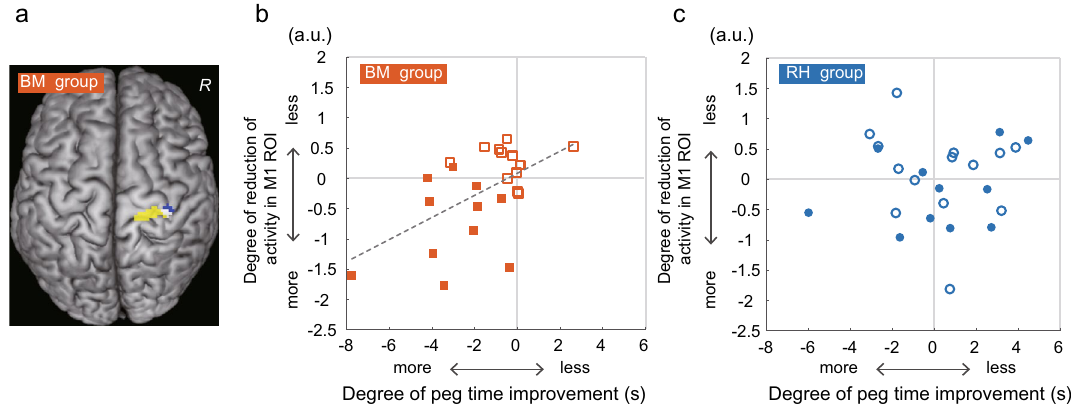
Figure 5. Relationship between the degree of reduction in ipsilateral M1 activity and peg time improvement. ( a ) Significant cluster (yellow and white areas) in which the degree of activity reduction was correlated with peg time improvement in the BM group. The cluster is superimposed on the MNI brain. ( b , c ) Relationship between the degree of reduction of activity (a.u.; vertical axis) in the M1 ROI (blue and white areas in panel a ) and peg time improvement (s; horizontal axis) in each group ( b for the BM group, c for the RH group). In each panel, the filled symbols represent data obtained from the participants who exhibited ipsilateral M1 hyperactivation (activity in the M1 ROI was greater than 0) before the training. The open symbols represent data obtained from the participants in whom ipsilateral M1 deactivation was preserved (activity in the M1 ROI was smaller than 0) before the training. The dashed line in panel ( b) indicates a regression line fitted to the data. a.u. arbitrary unit, BM bimanual, MNI Montreal Neurological Institute, R right hemisphere, RH right